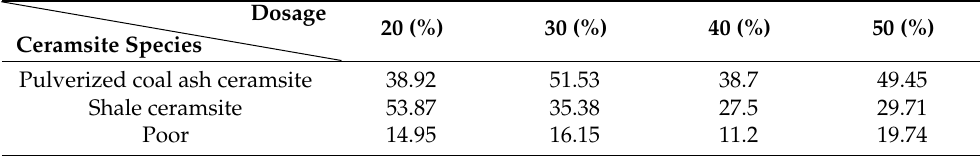
Table 3. Analysis of the 7 − day compressive strength of concrete.